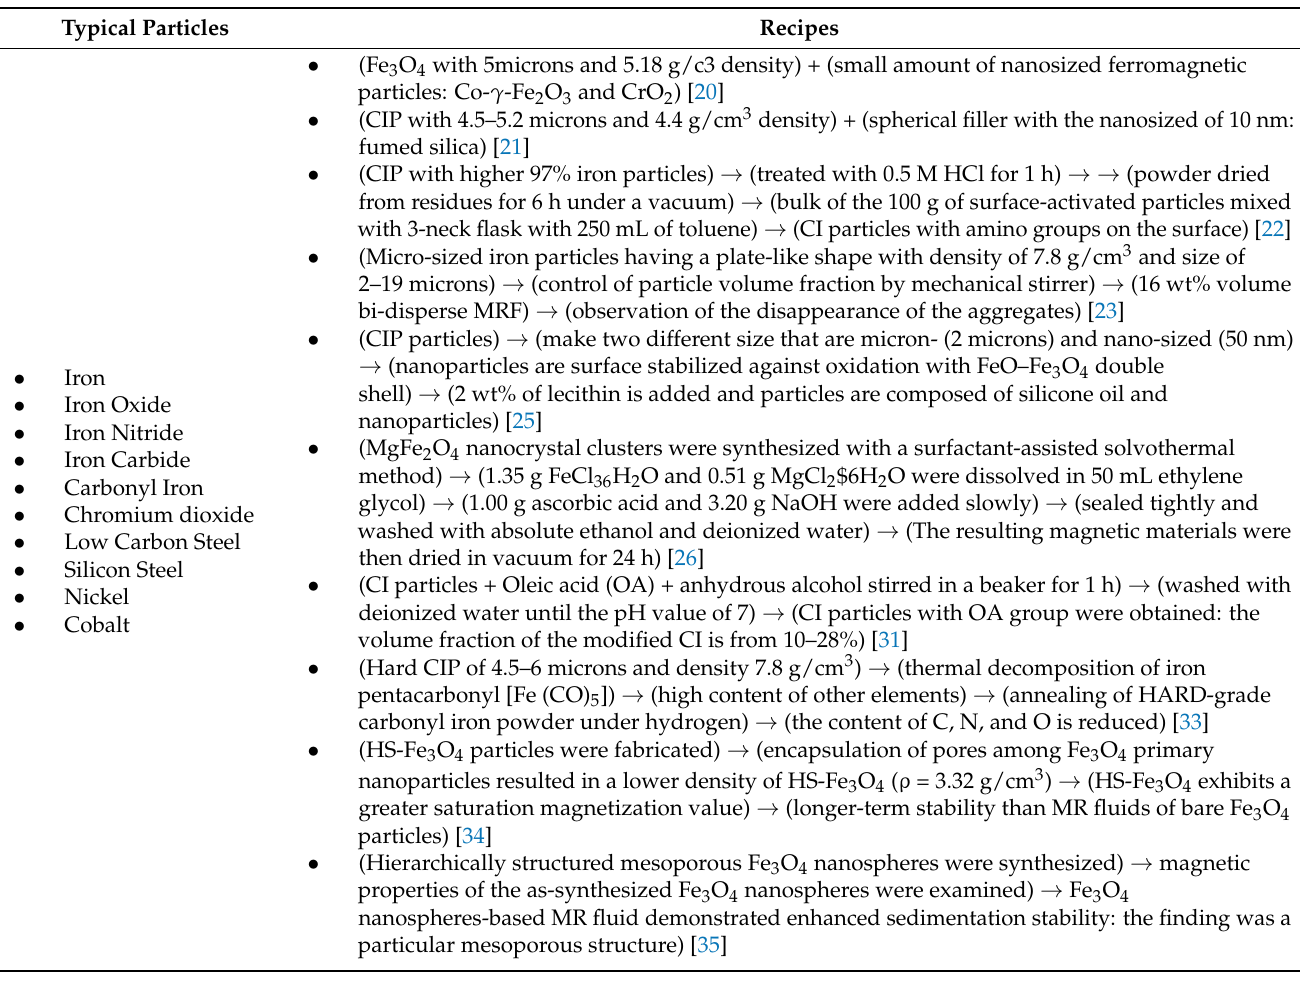
Table 1. Particle Modification for Improvement of Sedimentation